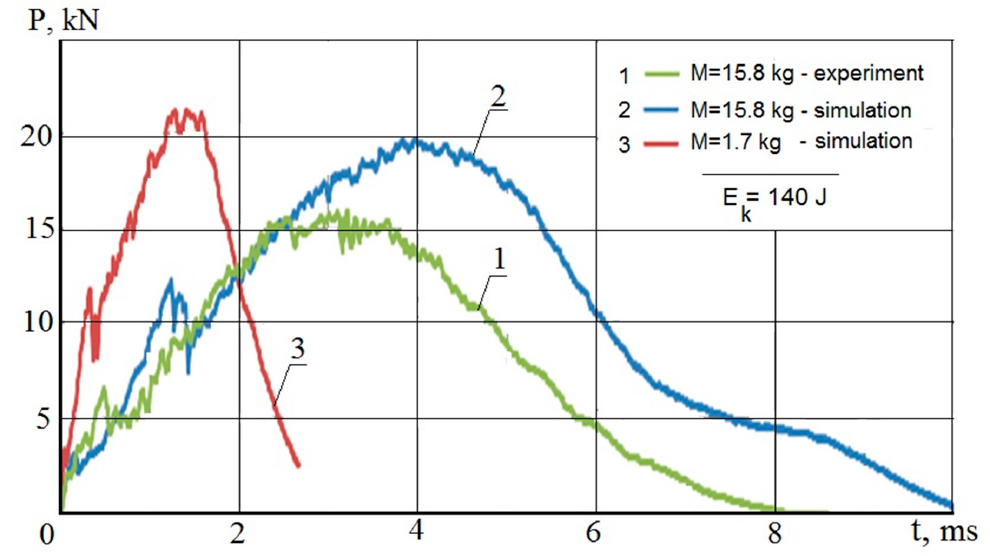
Figure 3. Contact force between impactor and panel. P —force caused by impactor; t —time; E k — kinetic energy.